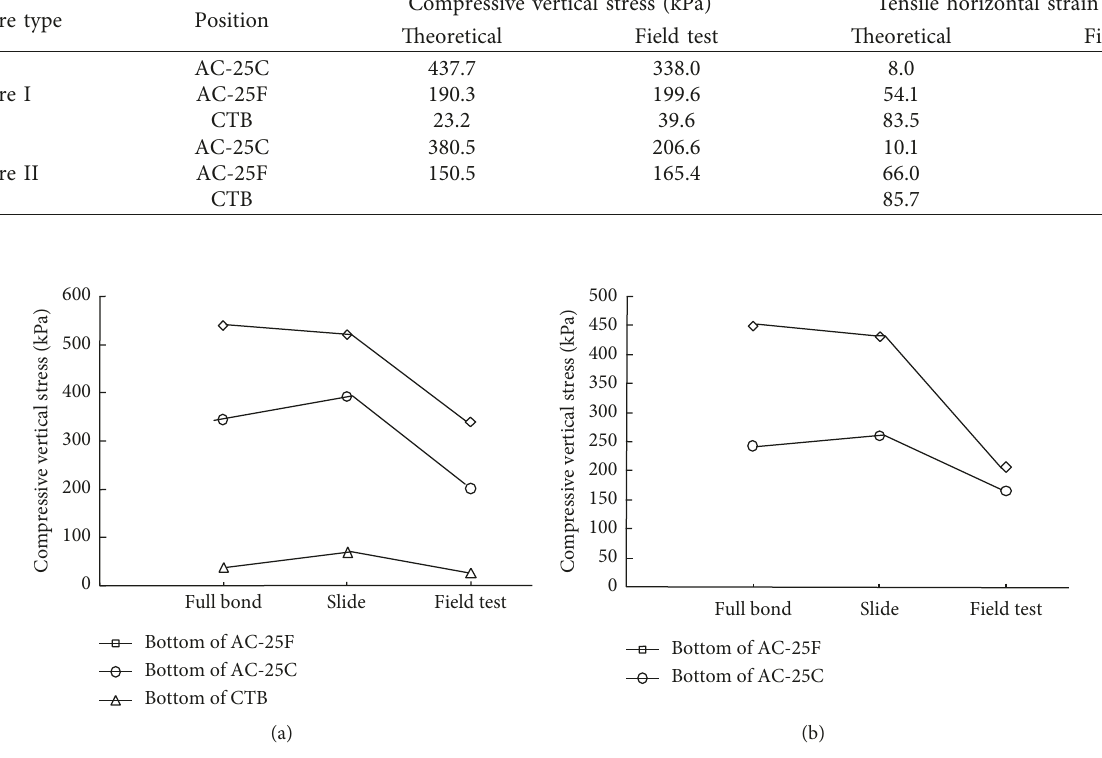
Figure 14: Effect of bonding condition on compressive vertical stress. (a) Structure I. (b) Structure II.